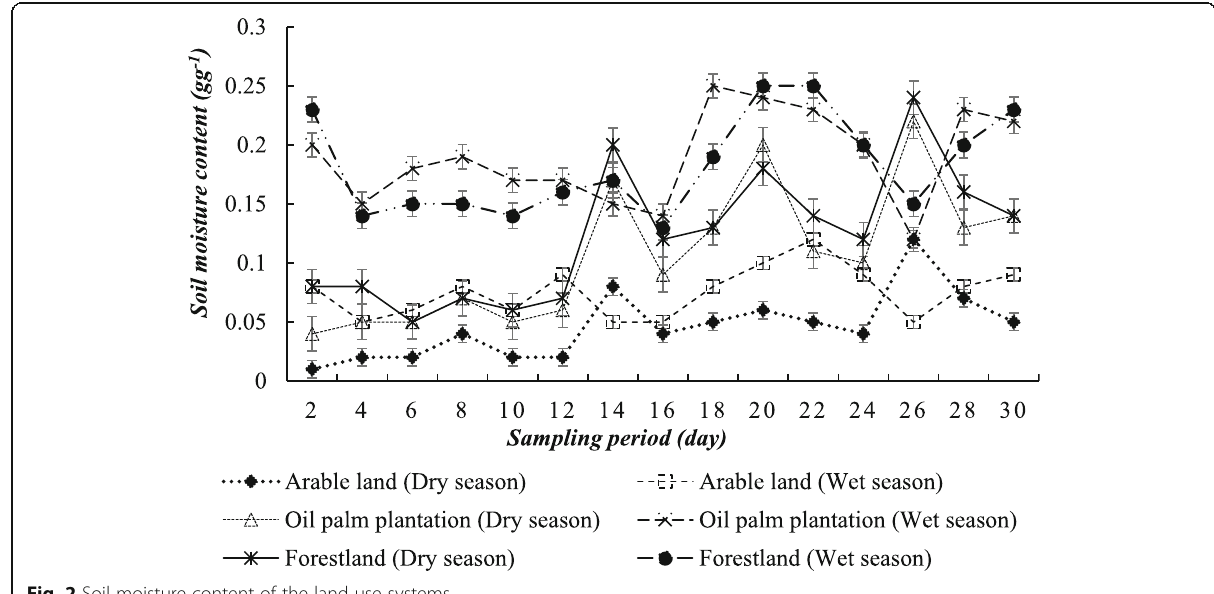
Fig. 2 Soil moisture content of the land-use systems